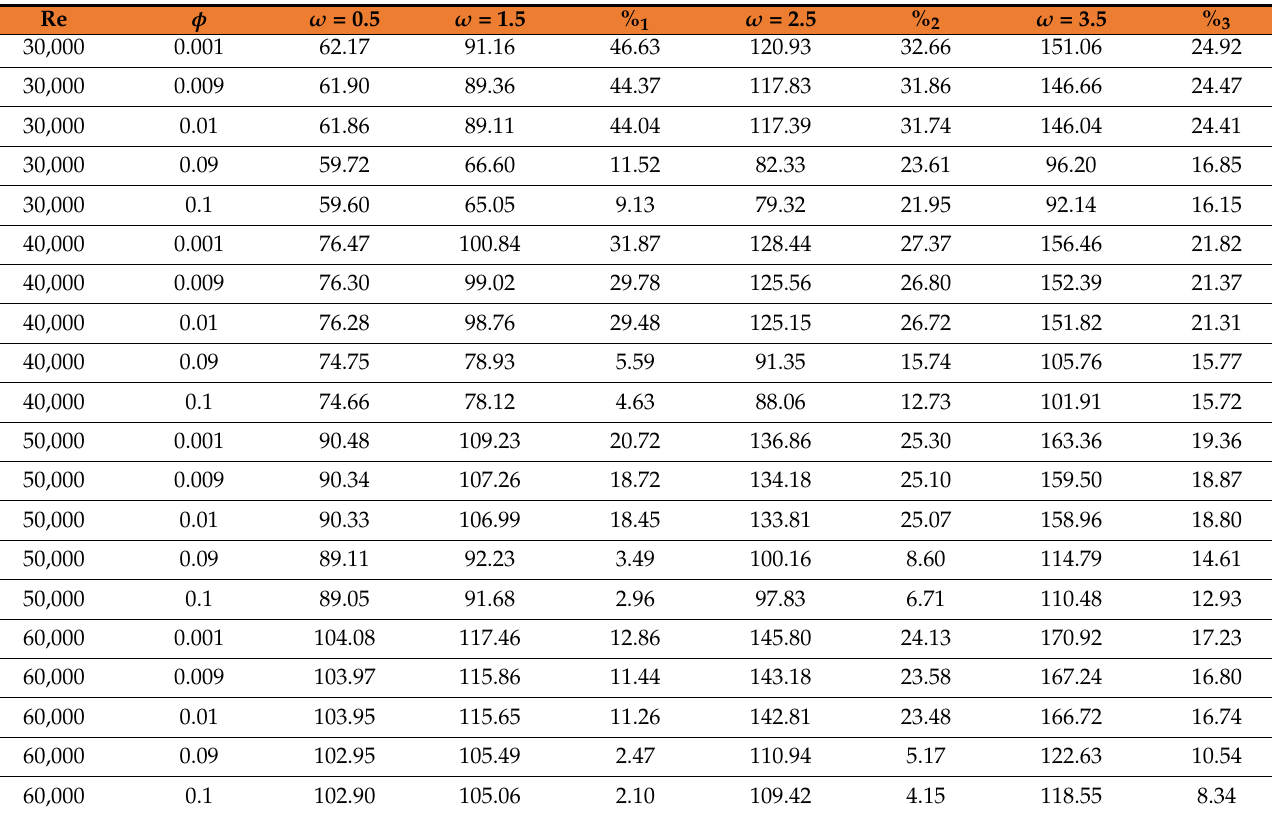
Table 4 details the precise impacts of altering the Reynolds number, cylinder rotation, and nanofluid volume fraction. Table 4. Average Nusselt number at the outlet of the channel and with percentage increments when the rotation of the cylinders changes by one